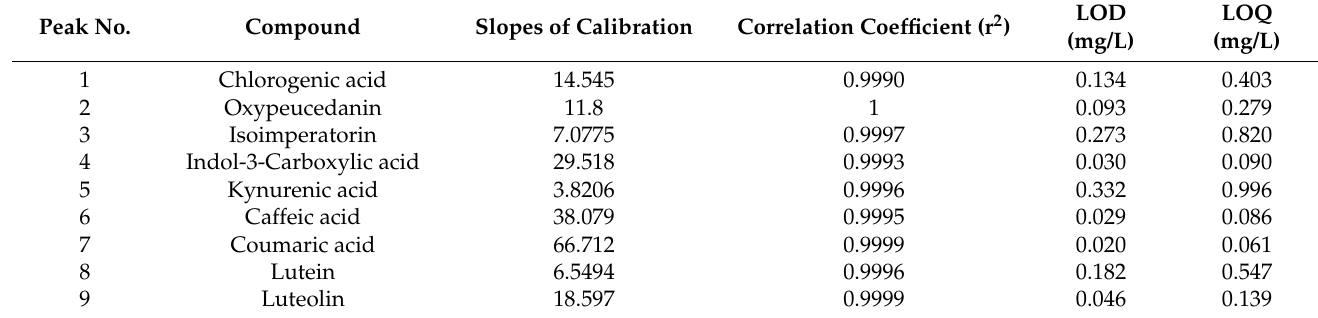
Table 2. Calibration curves data for the quantification of polyphenolic compounds in Gynura procumbens . Peak No.